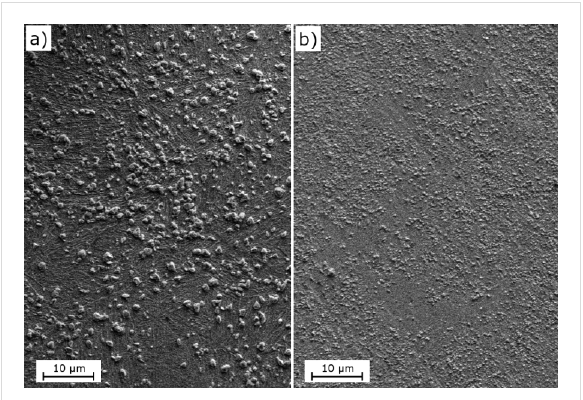
Figure 3: SEM image of a) CHT specimen and b) DCT specimen, showing a martenstic matrix with precipitated globular